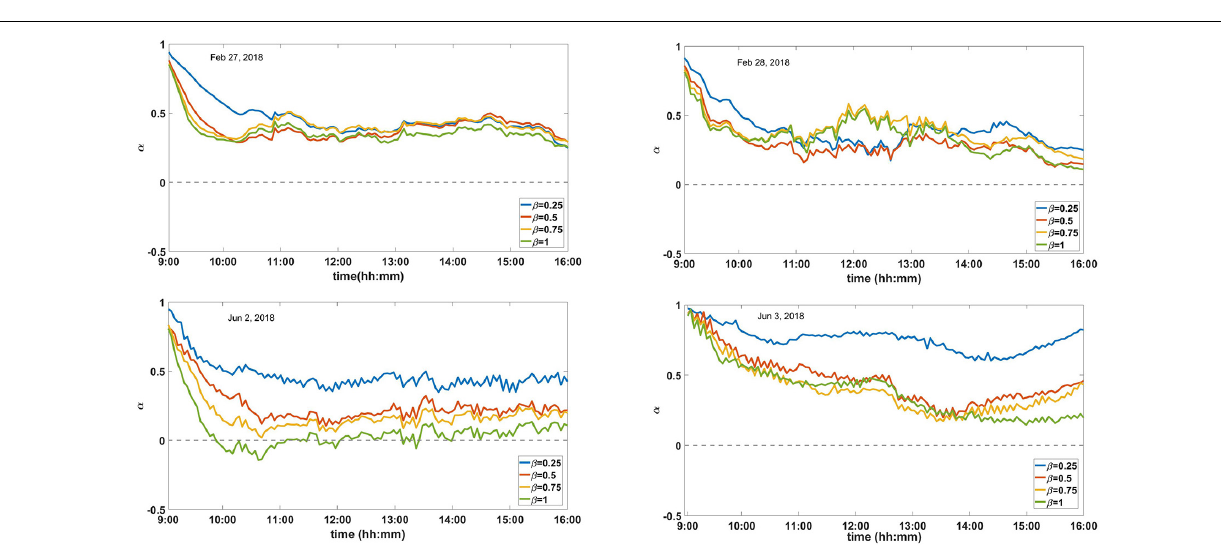
FIGURE 11 | Impact of different cloud cover coefficients on the performance of radiative cooling on (up-left) February 27, 2018, (up-right) February 28, 2018, (down-left) June 2, 2018, and (down-right) June 3,